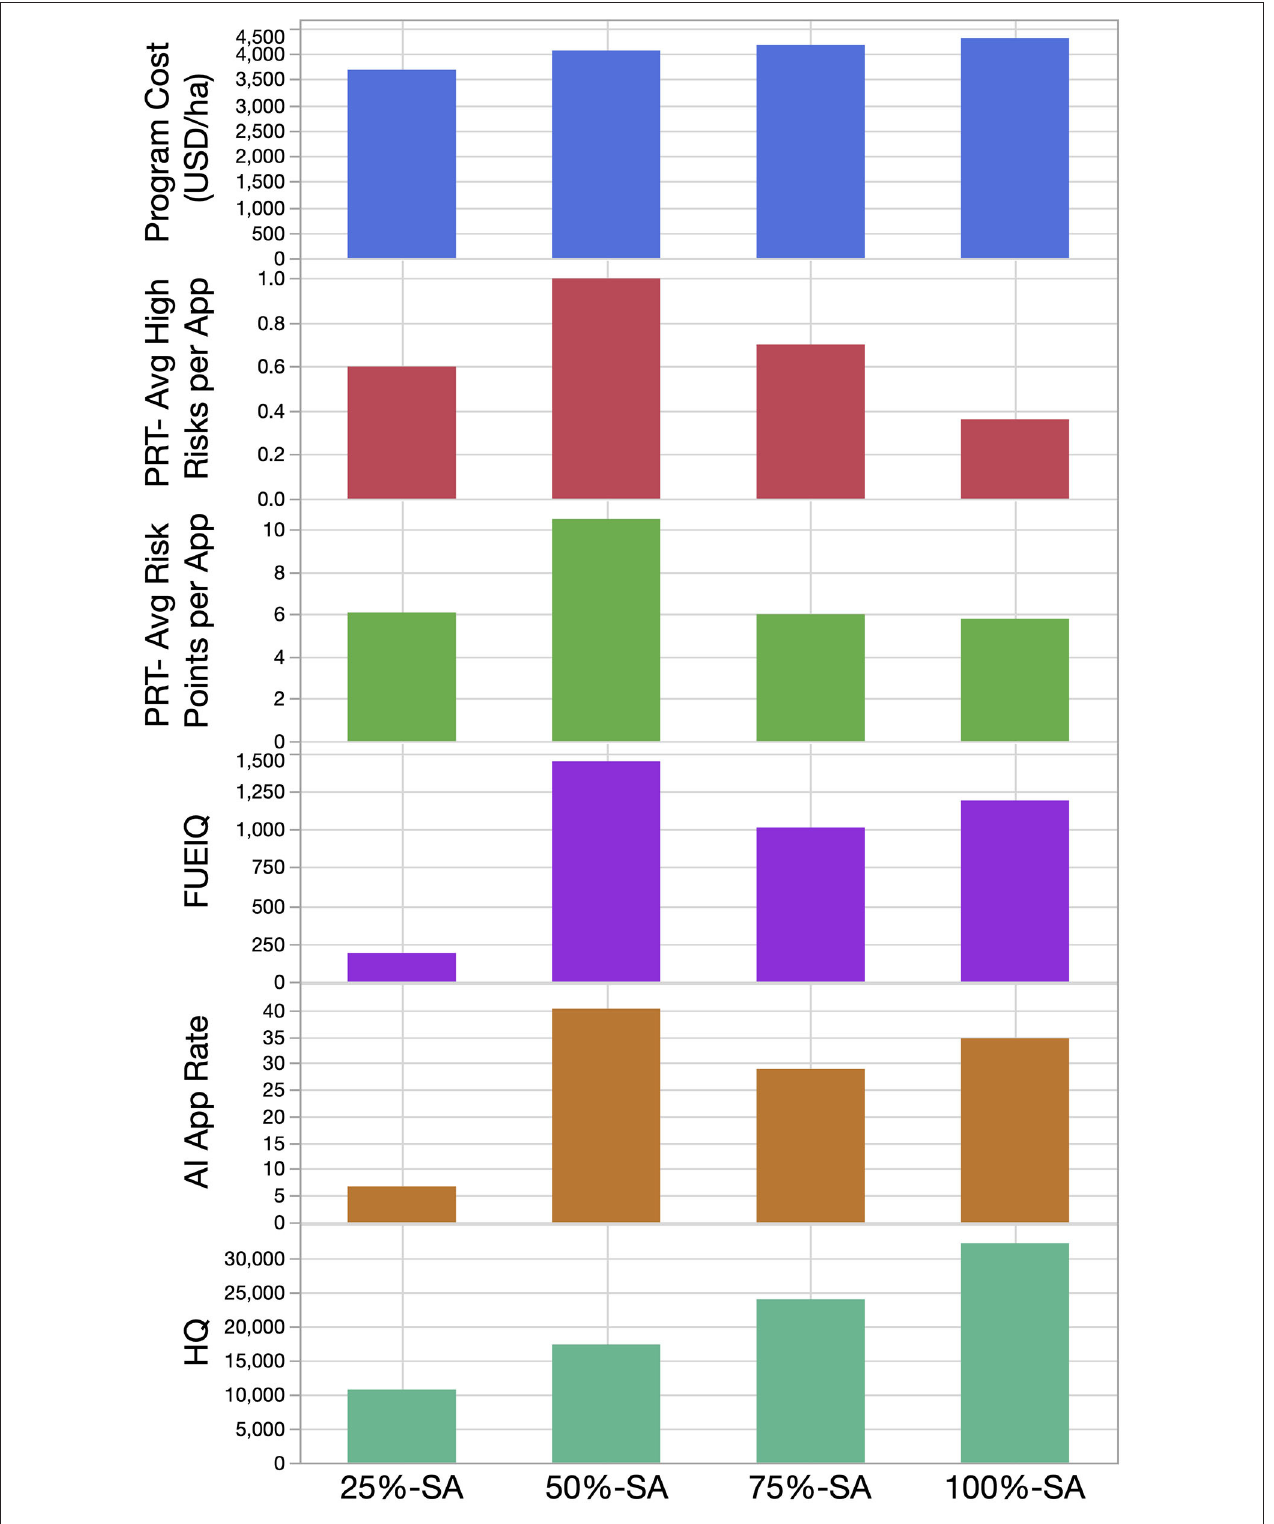
FIGURE 2 | Pesticide risk and price of each treatment program in the State Risk Comparison Study according to the five pesticide risk indices used to quantify pesticide risk: HQ, Hazard Quotient; AI App Rate, Active Ingredient Application Rate; FUEIQ, Field Use Environmental Impact Quotient; PRT-Risk Points per App, Pesticide Risk Tool- Risk Points per Application; PRT-High Risks per App, Pesticide Risk Tool- High Risks per Application. The study included a control and four programs that were 100%, 75%, 50%, and 25% the pesticide risk of the statewide average (SA) as quantified by hazard quotient (HQ).